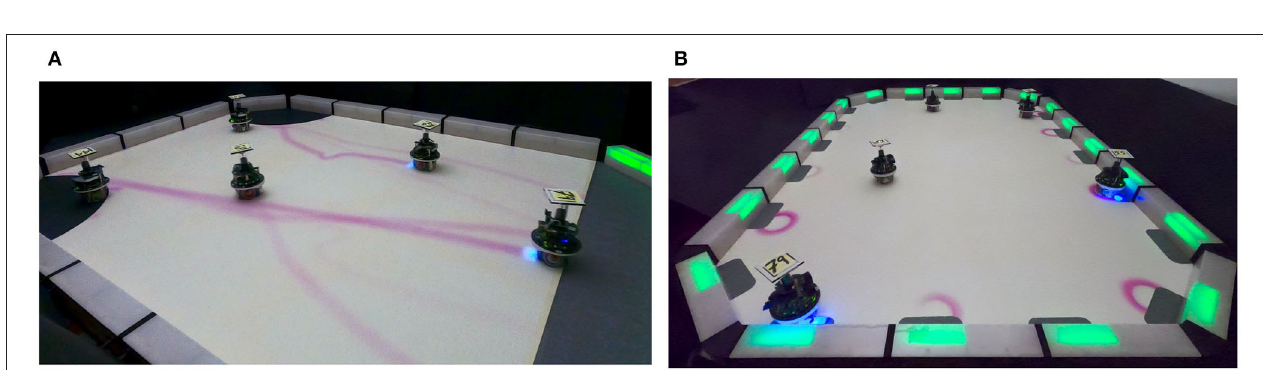
FIGURE 12 | (A) A swarm of e-puck robots depositing pheromone trails from source to nest using Phormica to perform FORAGING , and (B) a swarm of e-puck robots using Phormica to mark the workstations where they perform a task.